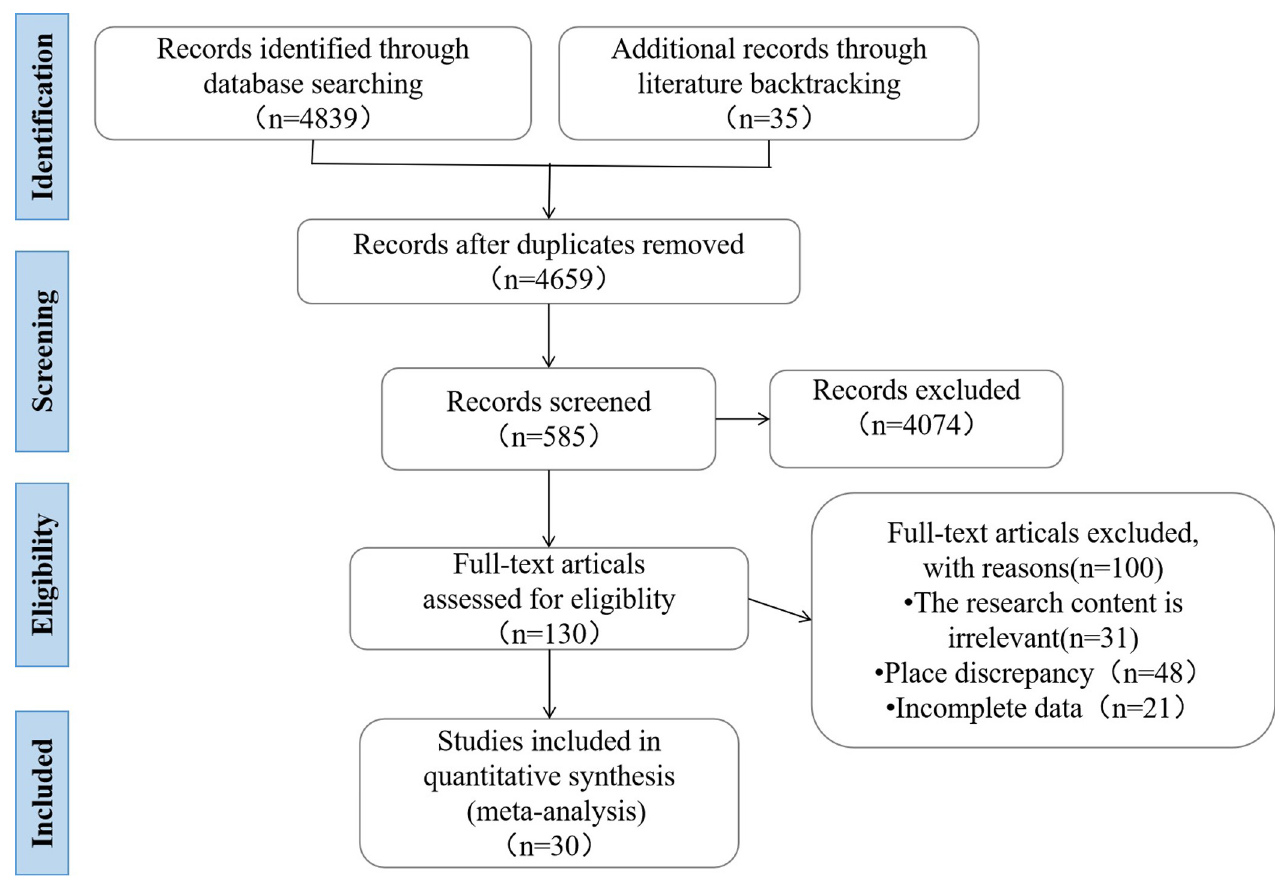
Fig 1. Flow chart of study